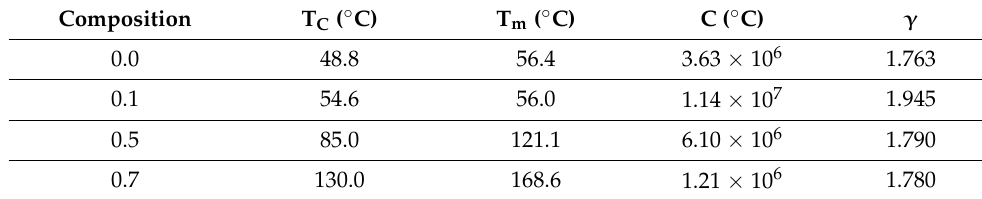
Table 1. The dielectric parameters of BZ 0.18 T–xBP 0.22 T (x = 0.0, 0.1, 0.5, 0.7) at 10